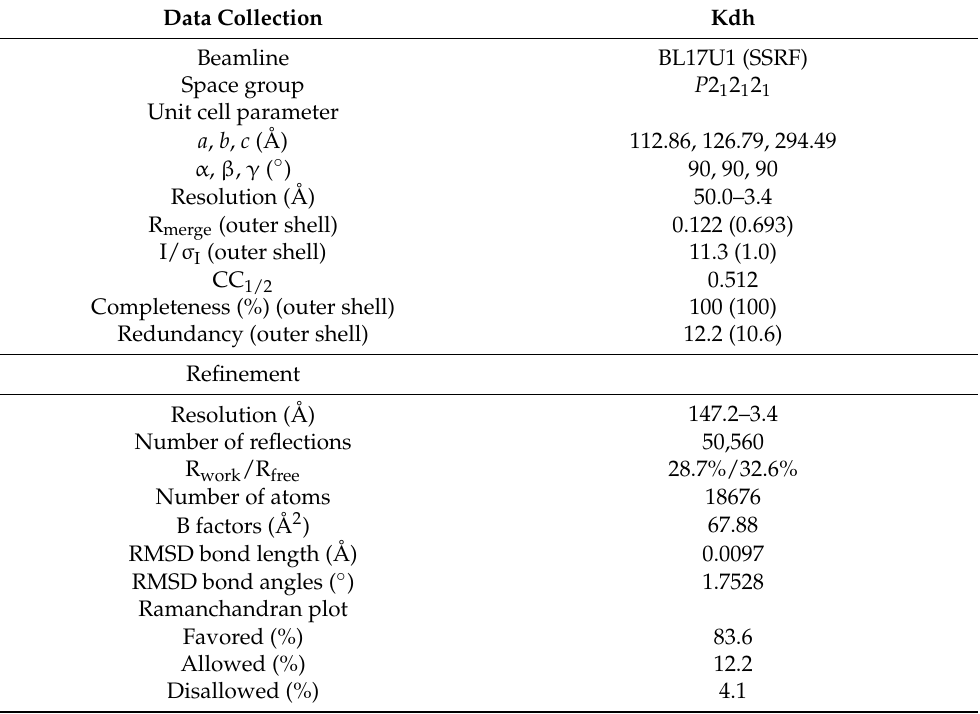
Table 1. Data collection and refinement